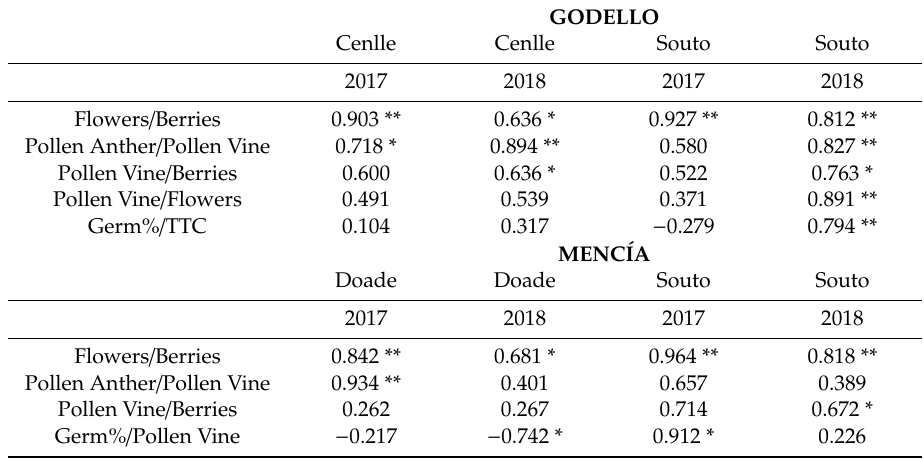
Table 2. Spearman’s rank correlation coe ffi cients for di ff erent parameters of the studied varieties ( p level: * < 0.05, ** <